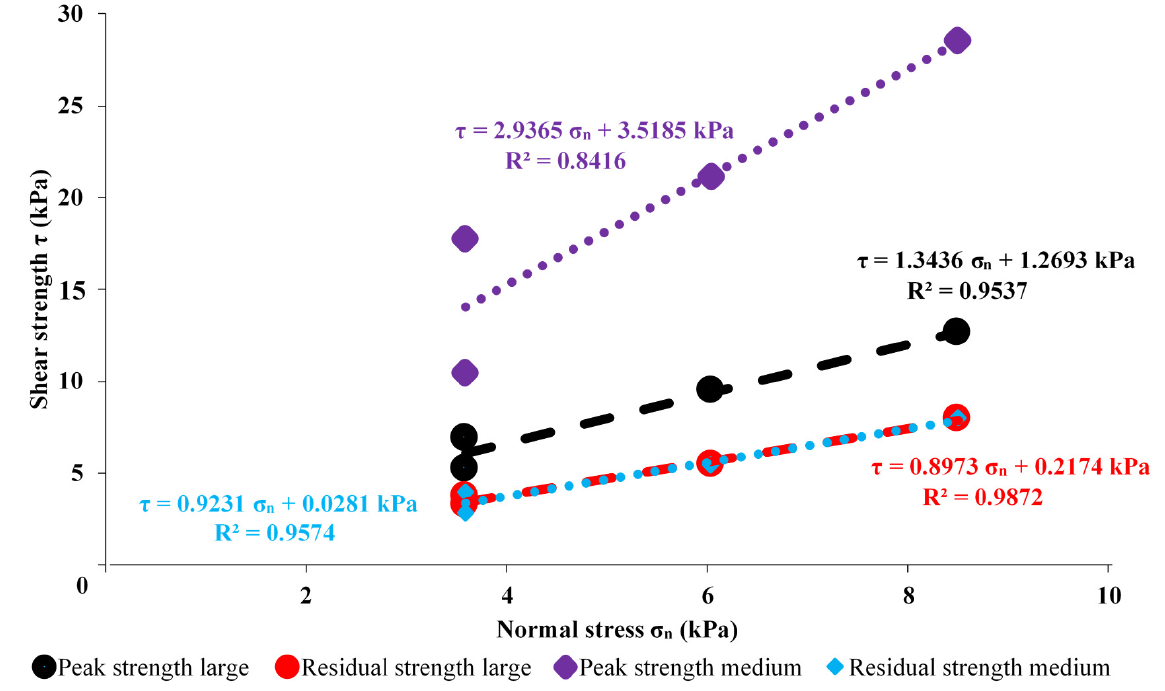
Figure 14. Peak and residual strength comparison for each stage at different scales.